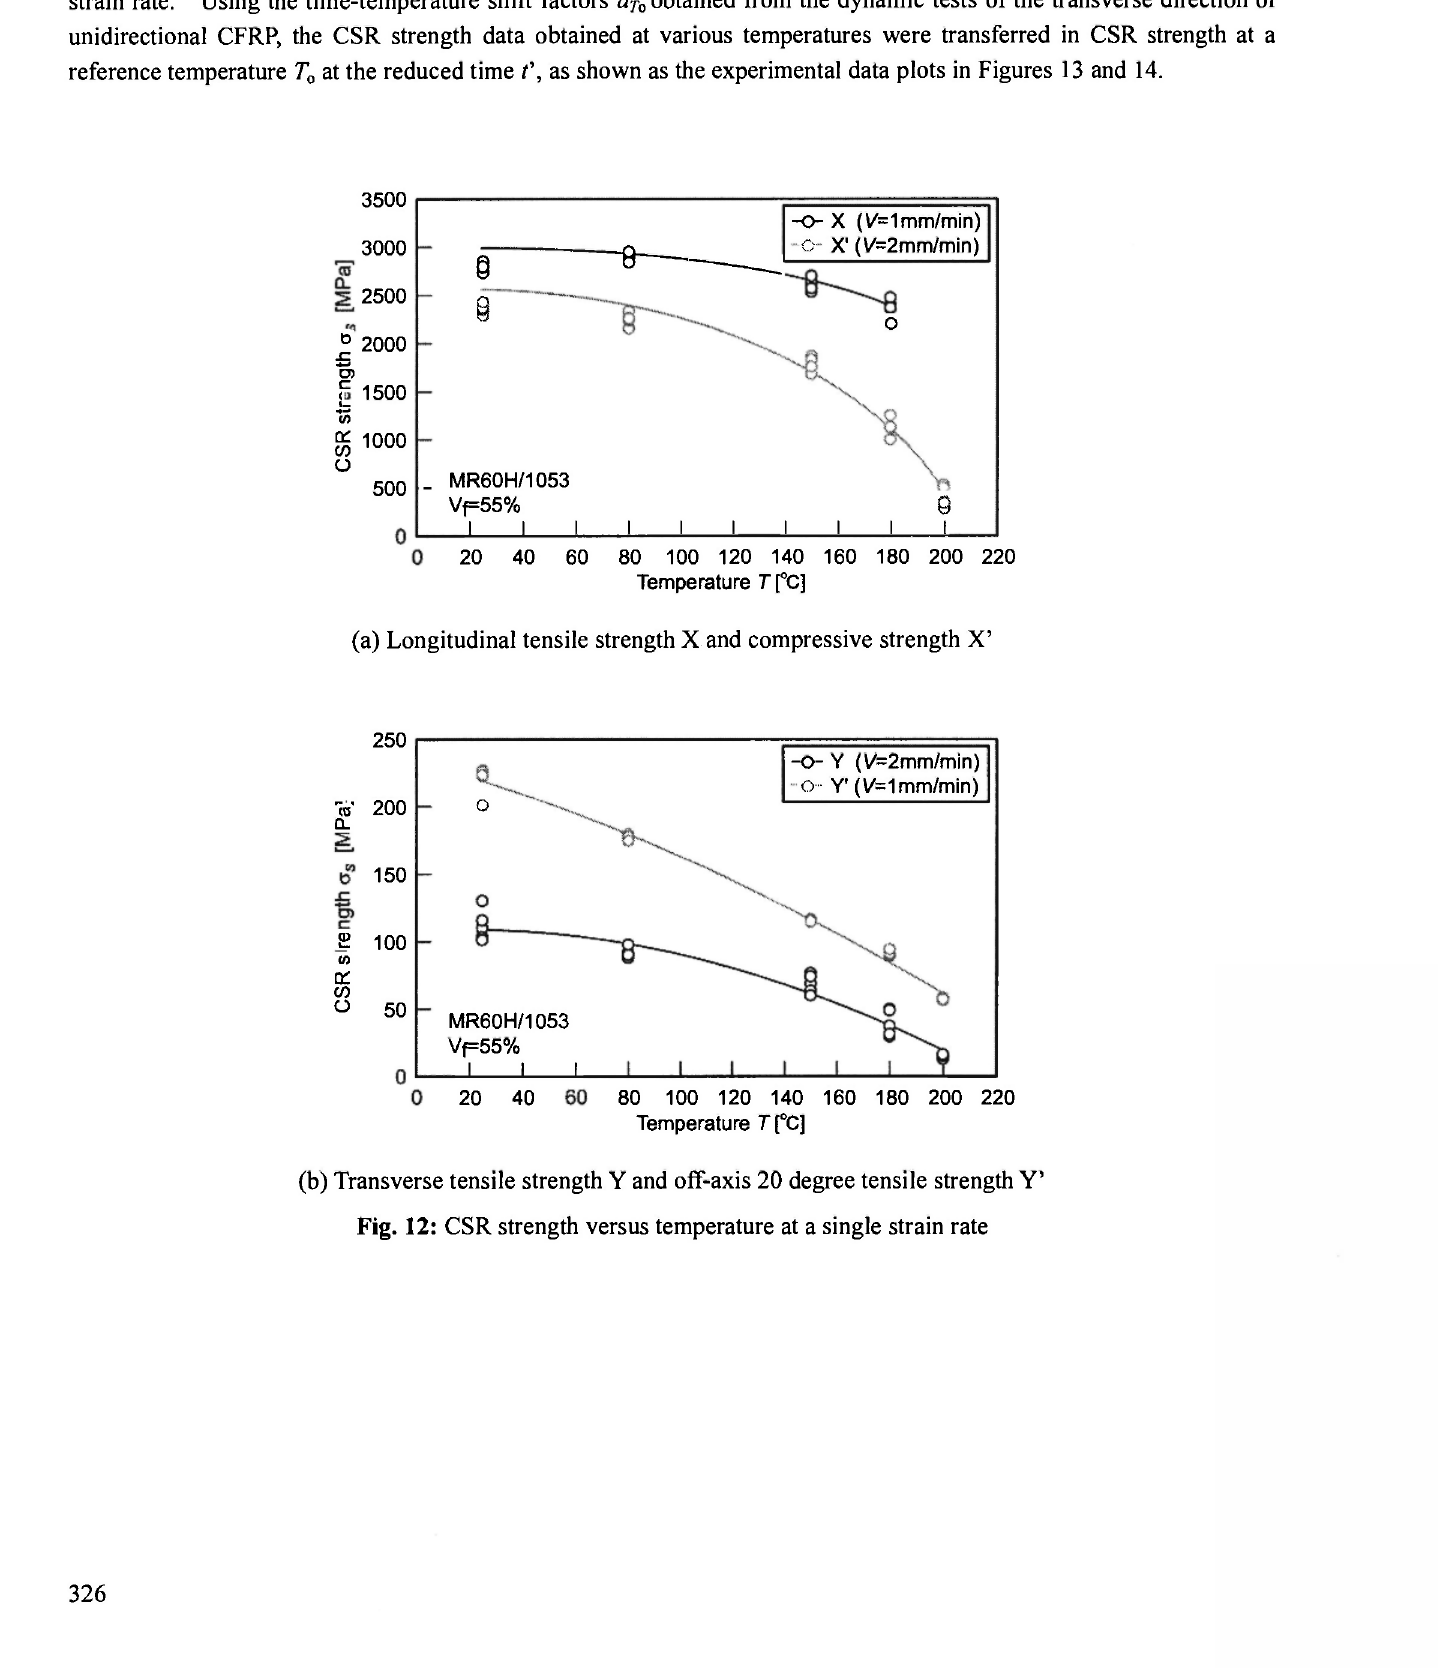
Fig. 12: CSR strength versus temperature at a single strain